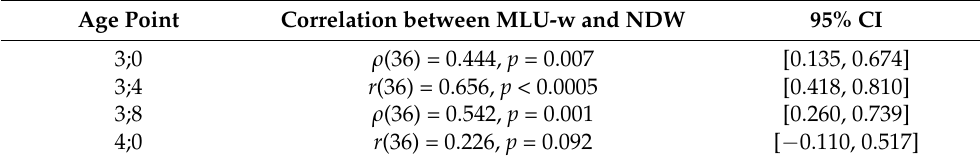
Table 1. Results of correlation analyses between MLU-w and NDW at each age point. Age Point Correlation between MLU-w and